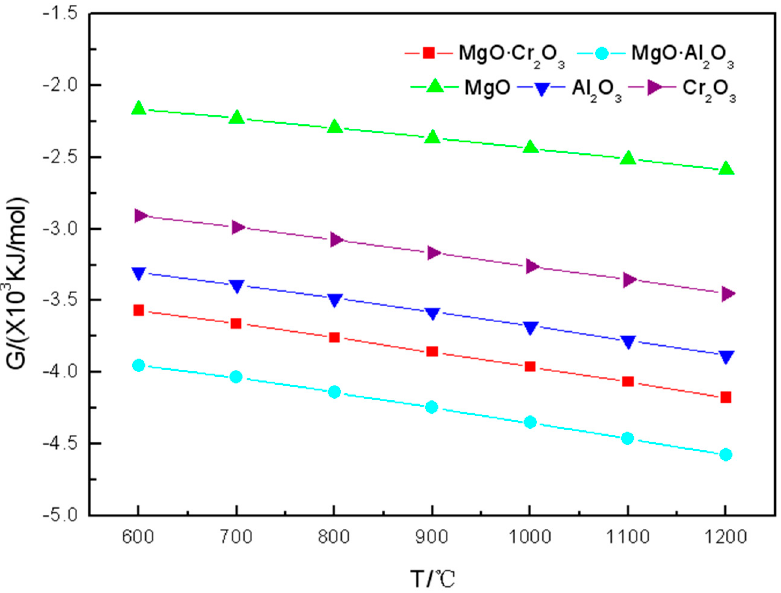
Figure 1. Gibbs free energy of the reaction between K 2 CO 3 and the five components of refractory materials in the 600–1200 °C temperature range. Table 1. Corrosion products and reaction equations of K 2 CO 3 reacting with the five components of refractory materials